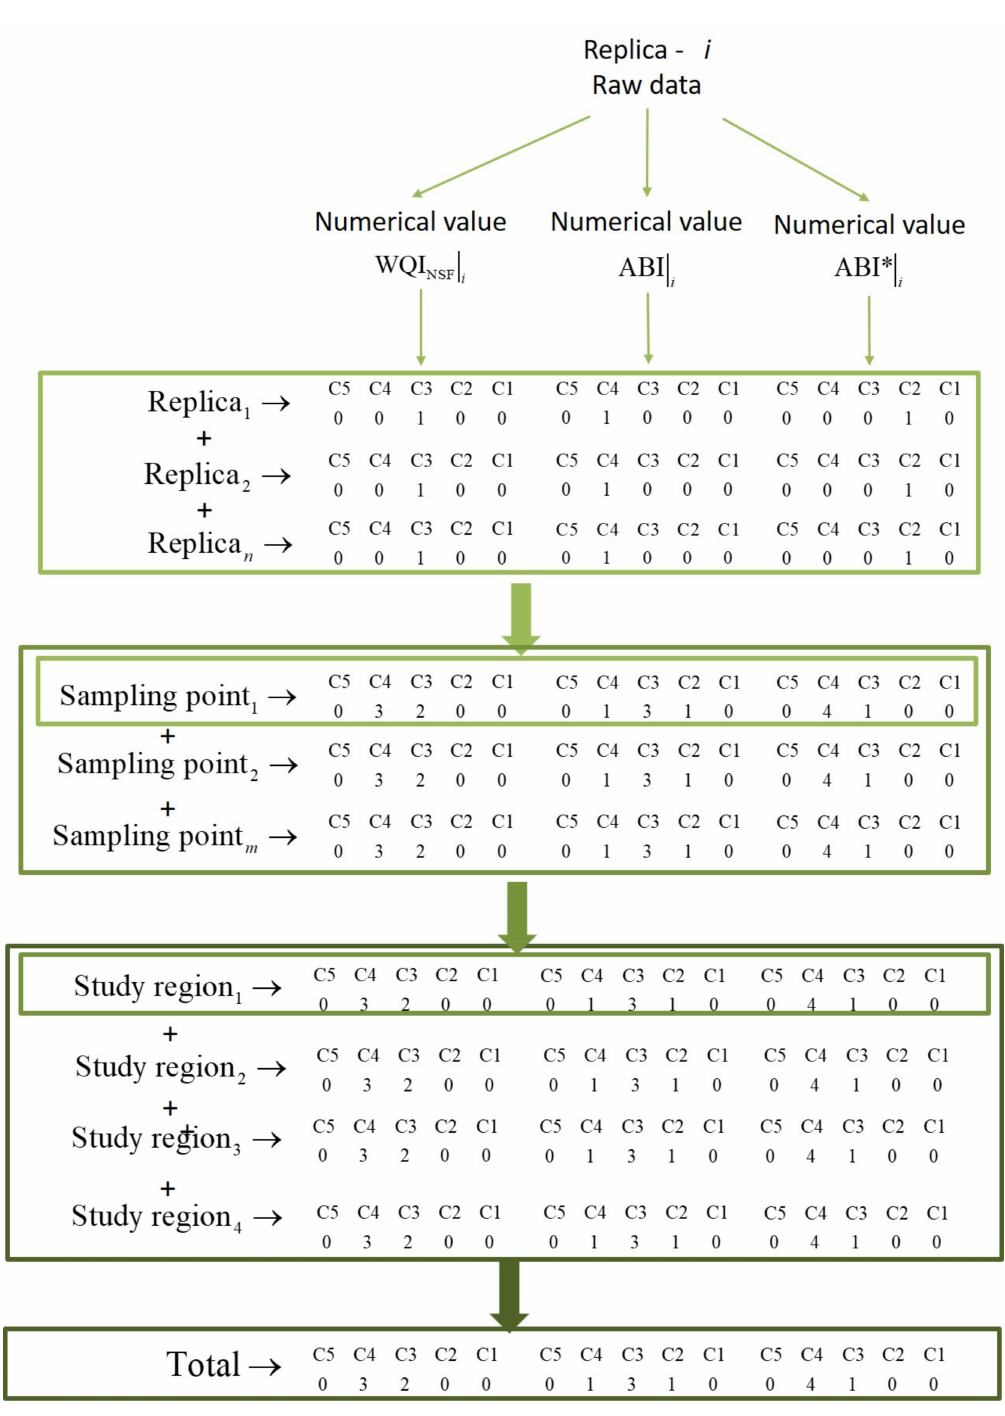
Figure 3. Water quality data per replica, sampling point, study region, and total. Data from Juval— Hight has been re-grouped as a fourth study